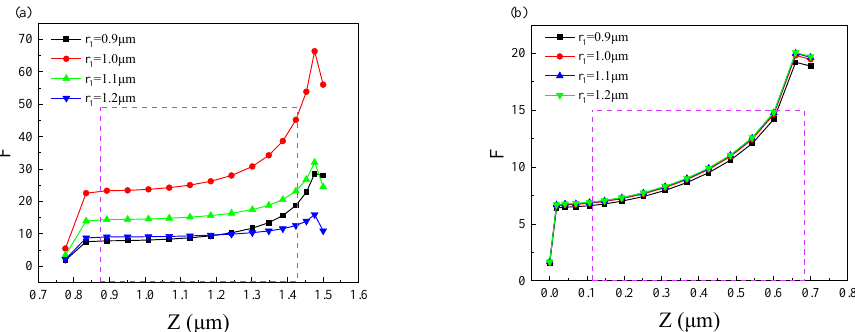
Figure 6. The effect of changing the r 1 of the top metal disk on the enhancement factor: ( a ) the effect of different r 1 on the enhancement factor of the top quantum well layer (QW1) and ( b ) the effect of different r 1 on the enhancement factor of the bottom quantum well layer (QW2).